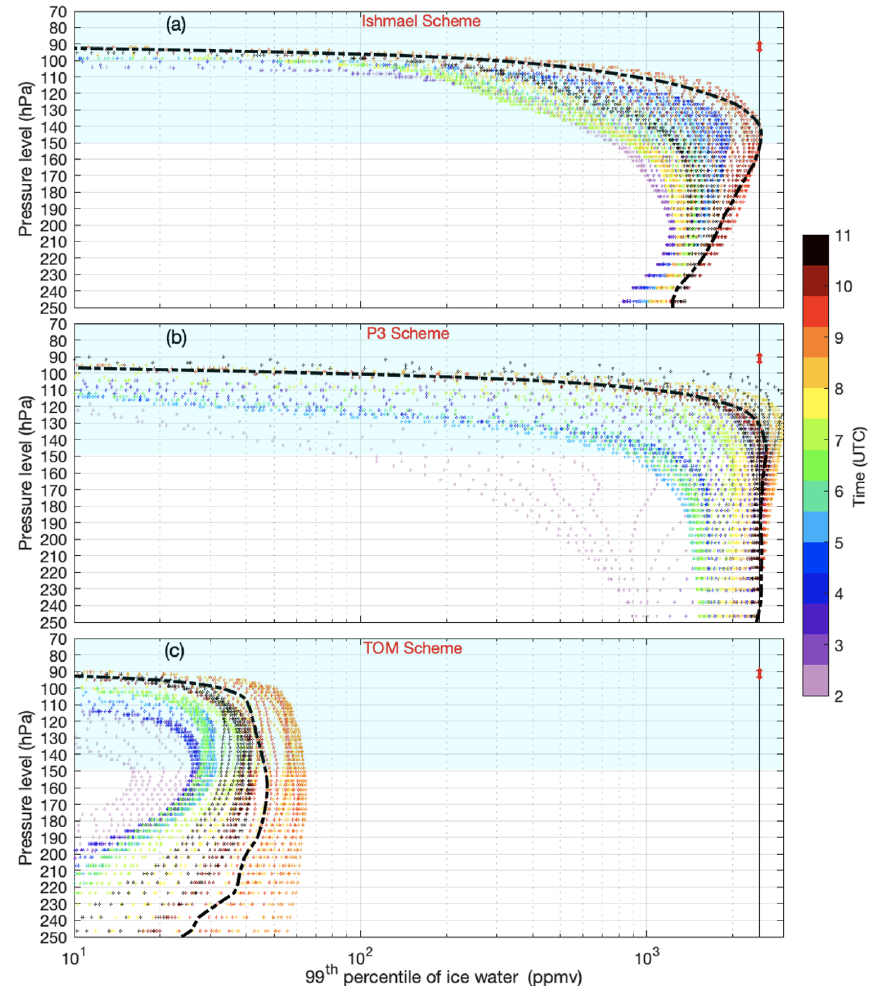
Figure 7. Profile of 99th percentile of simulated IWC below and within the TTL (cyan shared area) using grid spacing of 0.3km and three microphysics schemes, i.e., (a) ISHMAEL, (b) P3, and (c) Thompson (TOM), color coded by time (UTC) from 02:00 to 11:00UTC. The dashed–dotted black line represents the simulated profile at 09:40UTC (timing of the first captured peak of IWC by aircraft). The red double arrow represents the observed value at the corresponding observation